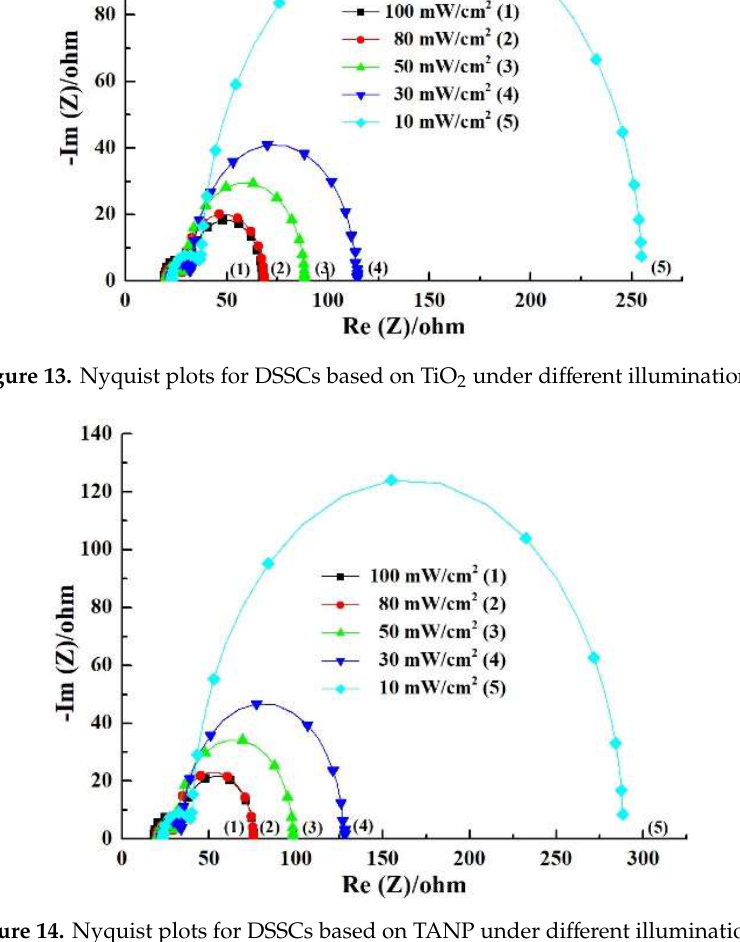
Figure 15. Nyquist plots for DSSCs based on TANLP under different illuminations.